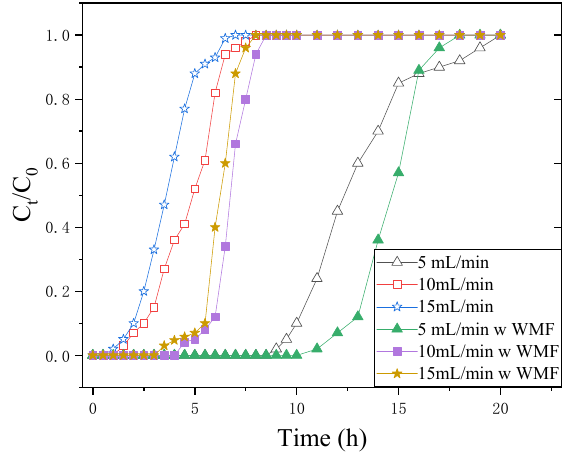
Figure 3. Breakthrough curves for nZNI/AC mediated Sb(III) removal at various flow rates. H = 20 cm; C 0 = 1 mg · L − 1 ; pH = 7; flow rate = 5, 10, and 15 mL · min − 1